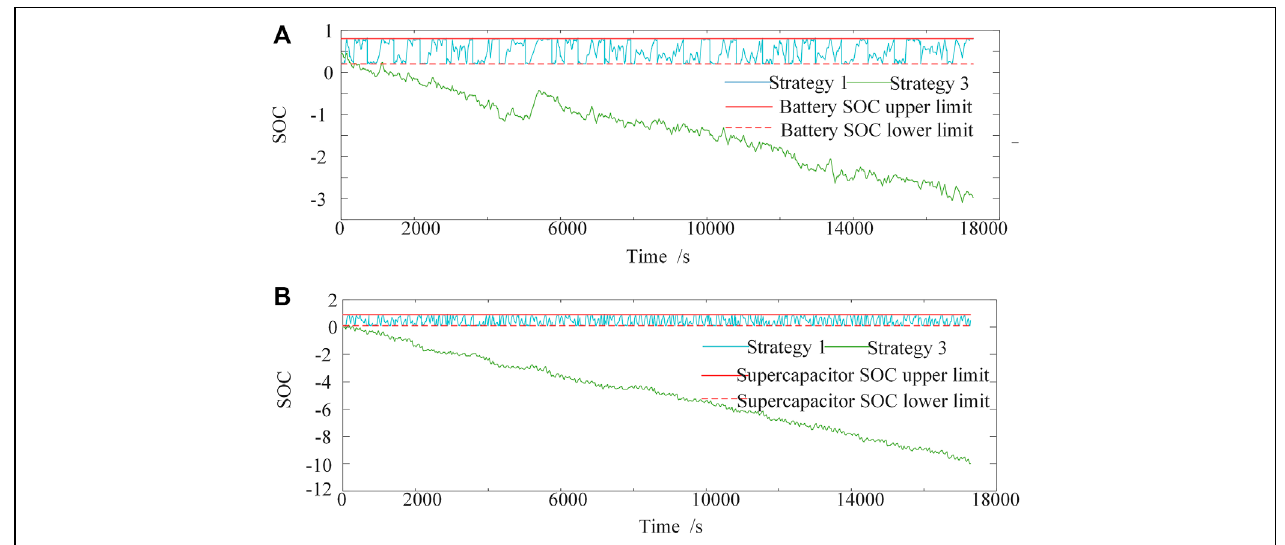
FIGURE 9 | SOC for strategy 1 and strategy 3 (A) Battery SOC. (B) Supercapacitor